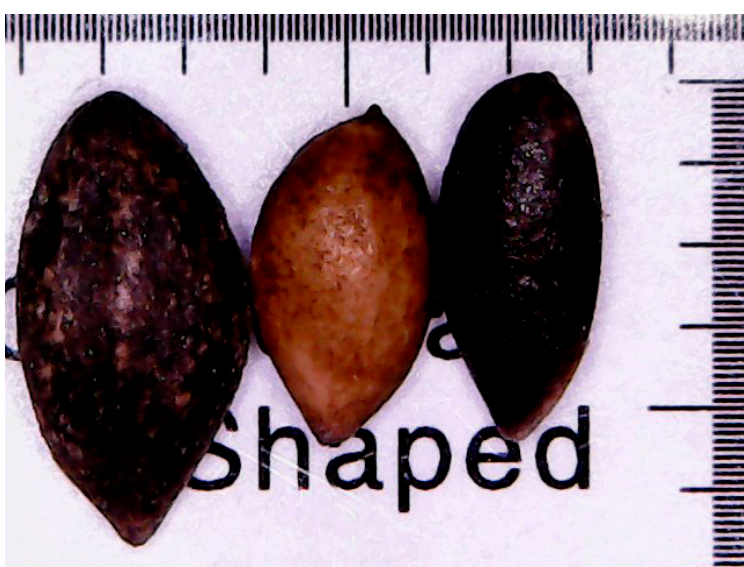
Figure 1. Characteristic type of Pinus sylvestris L. seeds in light (center), light dark (on the left), and dark (on the right) colour fractions used in the study. The photo was taken with a digital USB-microscope on a coordinate grid, between adjacent grid lines 0.1 mm.